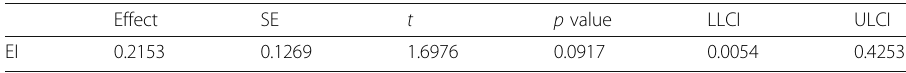
Table 6 Direct effects of PEE on EI